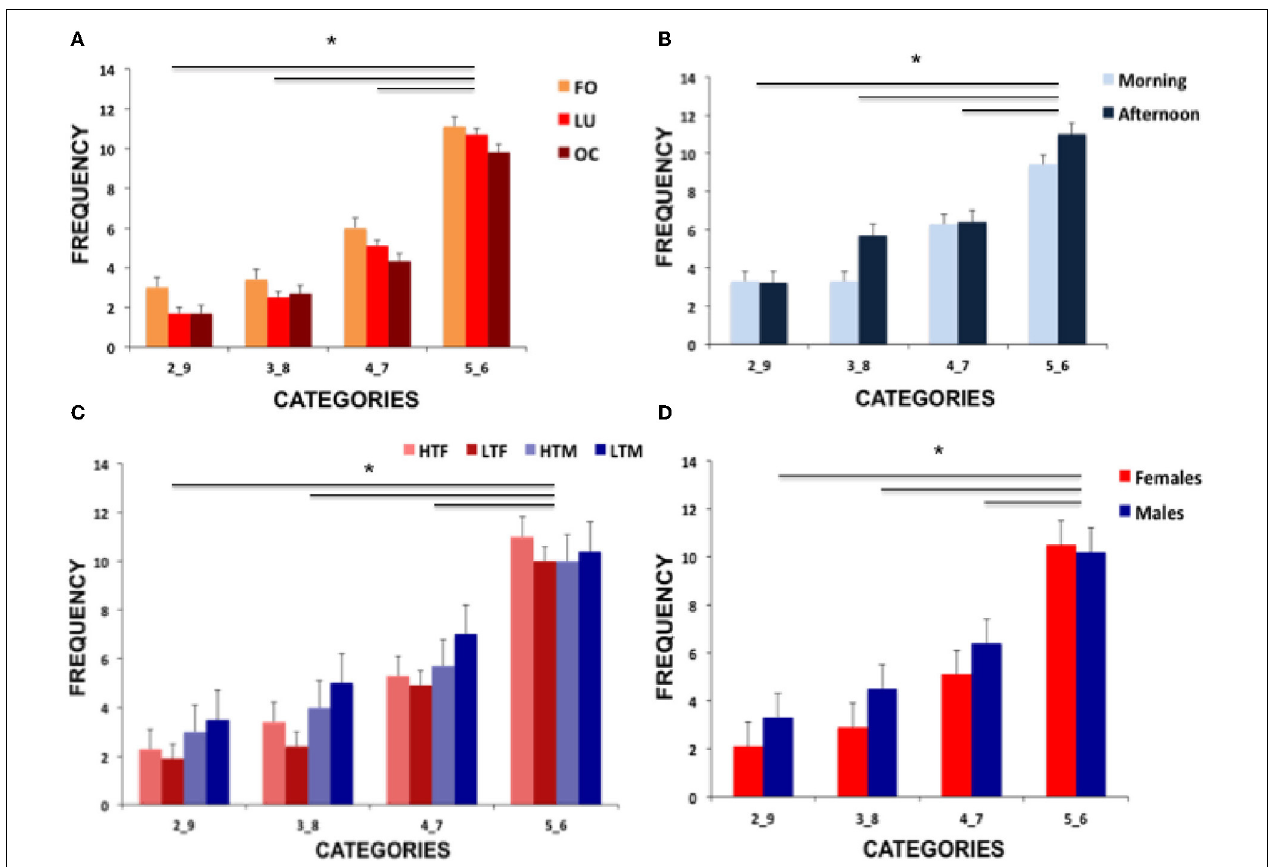
FIGURE 2 | Illustration of the results showing (A) frequencies of risk conditions for the three female groups (FO, follicular; LU, luteal; OC, oral contraceptive intake), (B) frequencies of the two male groups (morning and afternoon testosterone) and (C) frequencies of the high vs. low